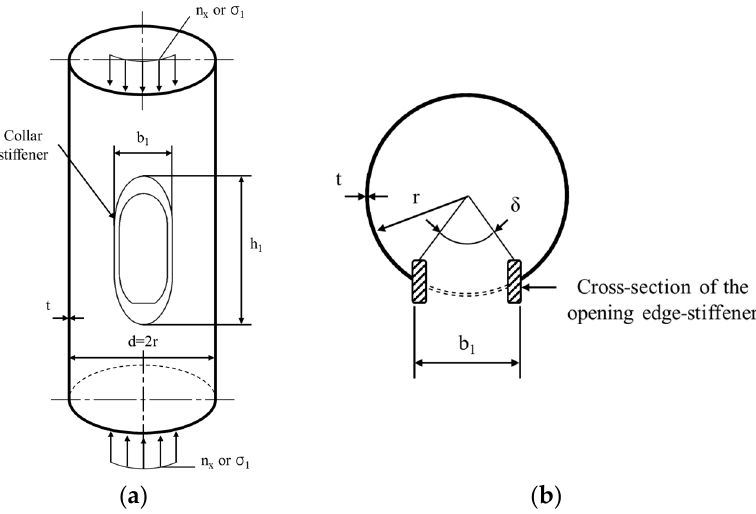
Figure 3. Circumferentially edge-stiffened openings [26]: ( a ) overview; ( b ) plan view.